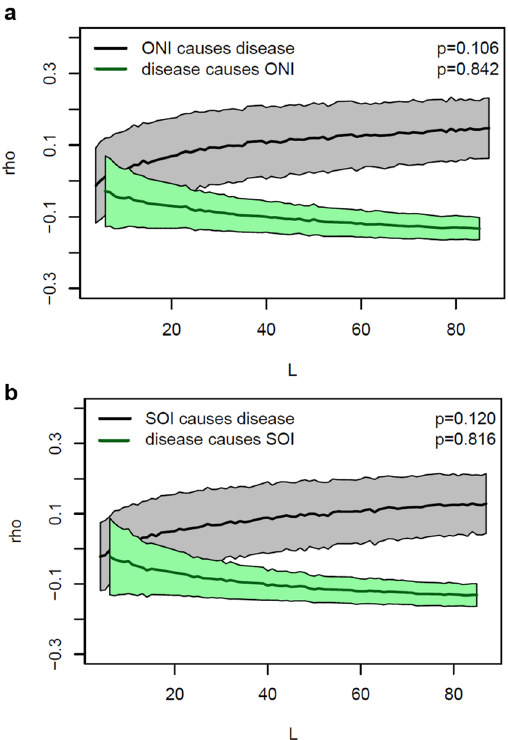
Figure 4. Multispatial convergent cross-mapping analyses. Lines and shaded regions indicate the mean ± 1 SD from 1000 bootstrapped model iterations. Causal forcing is indicated when the Pearson correlation coefficient ( ρ ) is greater than zero, for a large library length (L). Statistical significance (p) was used to determine whether the Pearson correlation coefficients for each process (ENSO and disease) were significantly greater than zero. ( a ) Oceanic Niño Index (ONI) and the prevalence of all coral diseases. ( b ) Southern Oscillation Index (SOI) and the prevalence of all coral